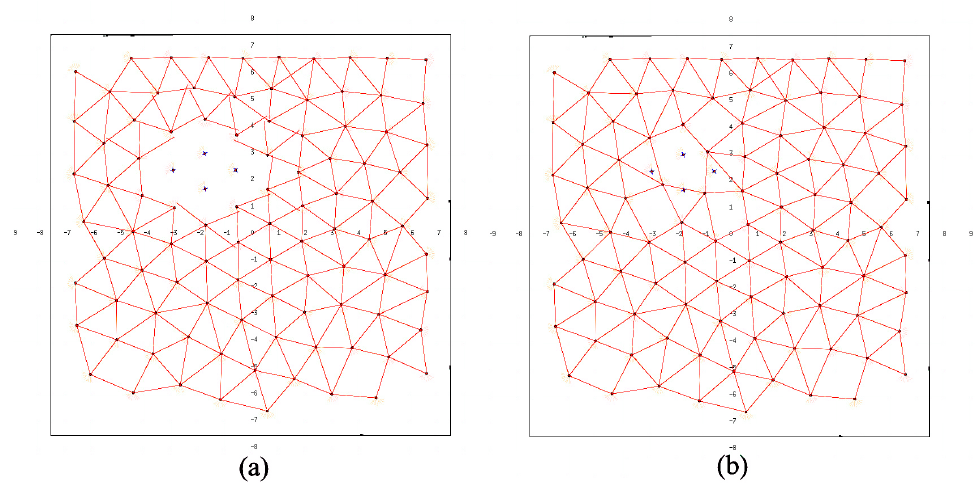
Figure 9. Self-healing using SPF for 100 robots in an environment with obstacles: ( a ) failure of four nodes; ( b ) reconfigured network.